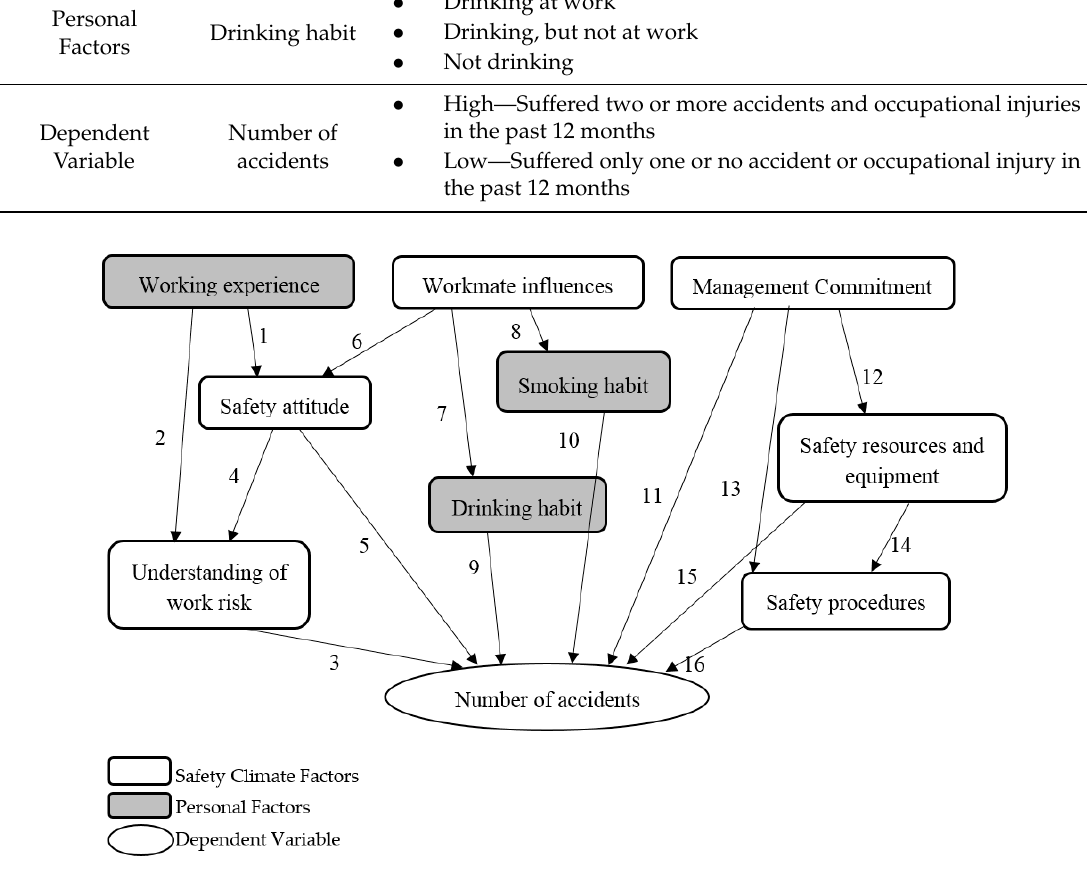
Figure 3. The established Bayesian Network structure. Table 3. Literature supporting the causal relationship of the identified